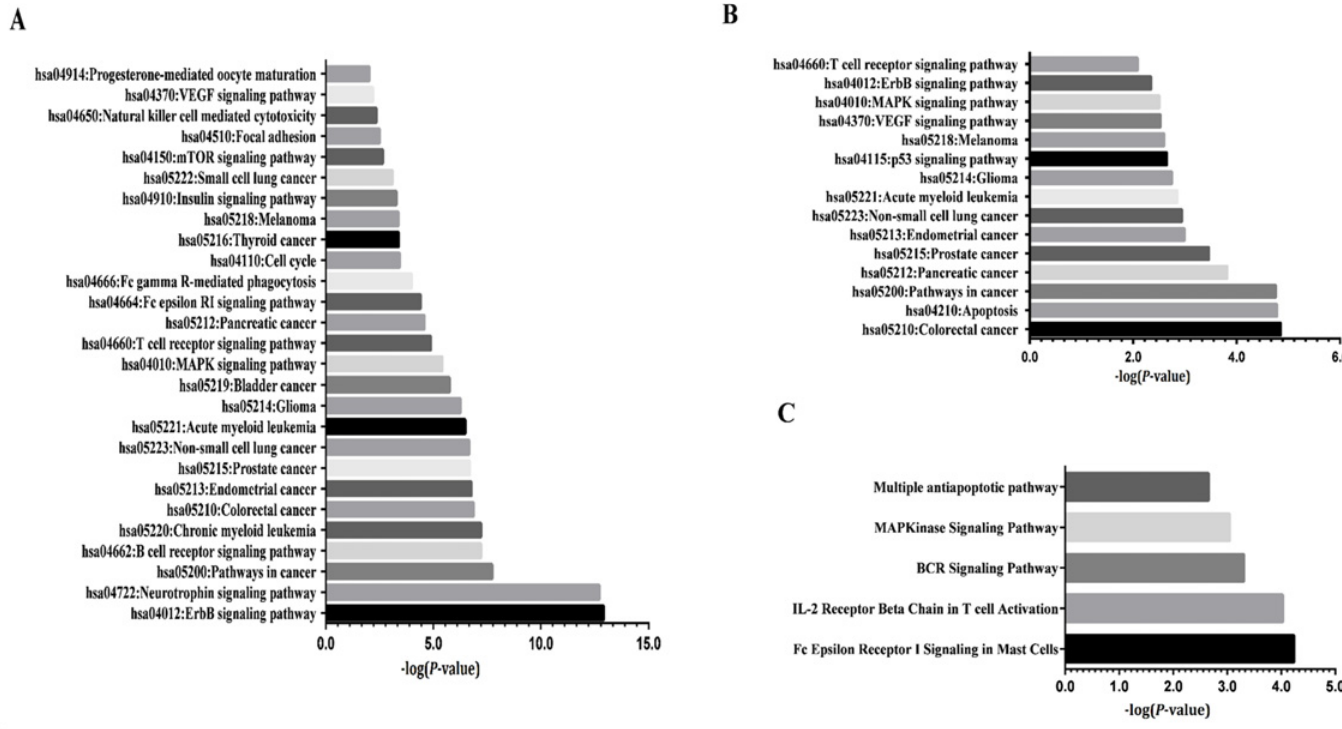
Fig 3. KEGG and BioCarta pathway functional annotations of differentially expressed up-regulated (A, C) and down-regulated (B) proteins ( P - values < 0.01, Benjamin < 0.05). Enrichment scores corresponding to each pathway provided by the DAVID annotation tool are displayed as − log P -values. Down-regulated proteins that were BioCarta pathway functional annotations only were enriched in apoptotic signaling in response to DNA damage.